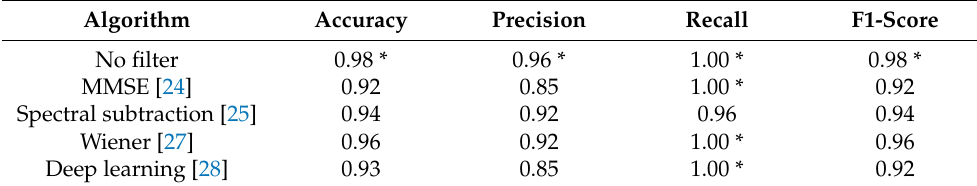
Table 15. Office Noise SNR 10. * is the best result for each particular measure.